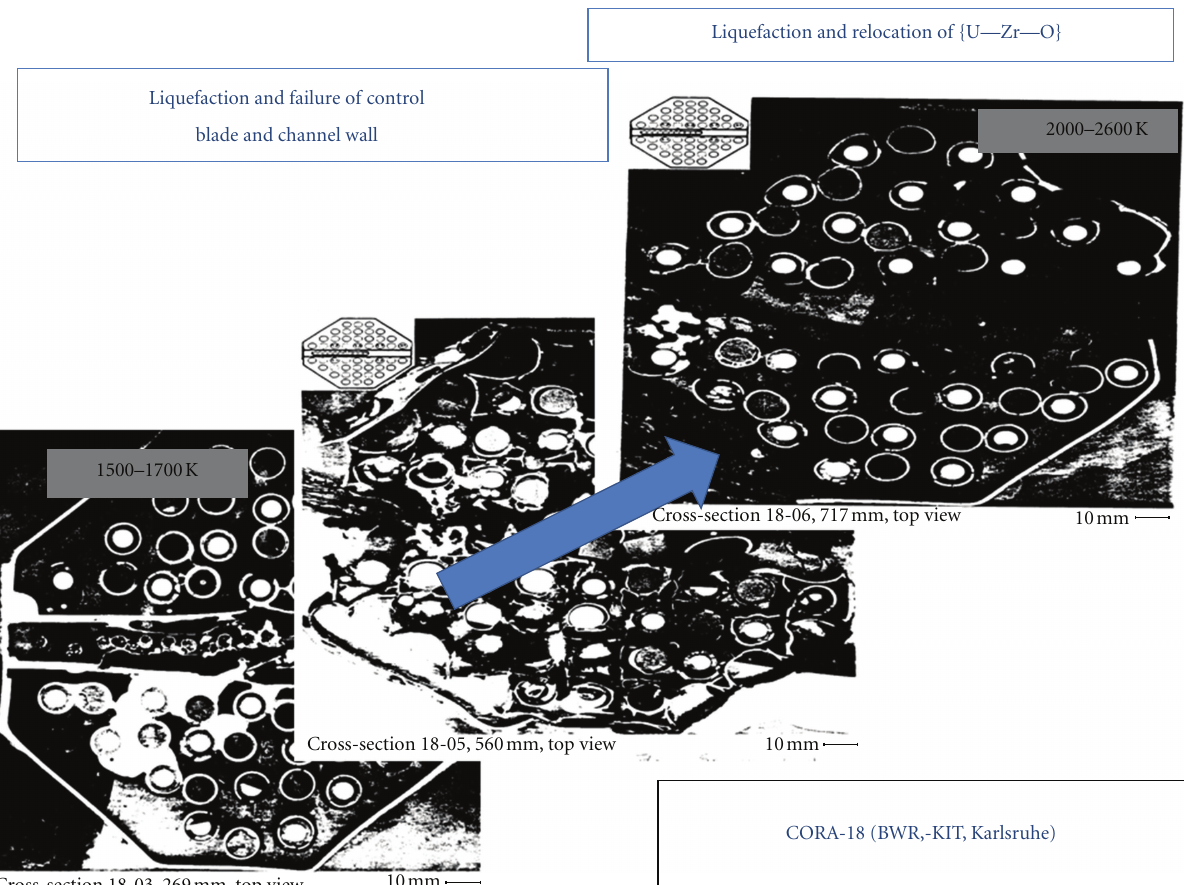
Figure 2: Horizontal metallographic cross-sections for CORA-18 showing destruction of control blade and channel box at temperatures between 1500–1700 K.